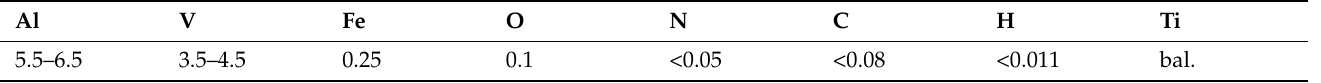
Table 1. Chemical composition of the commercial powders